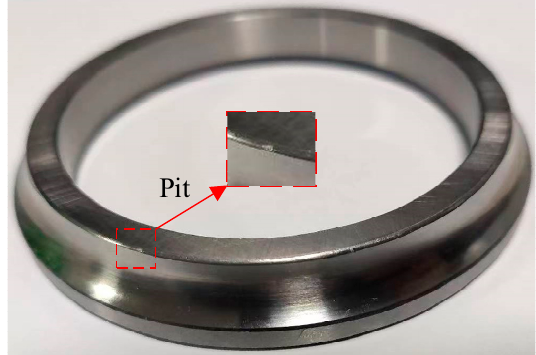
Figure 5. The pit on inner ring after bearing abrasive wear test.